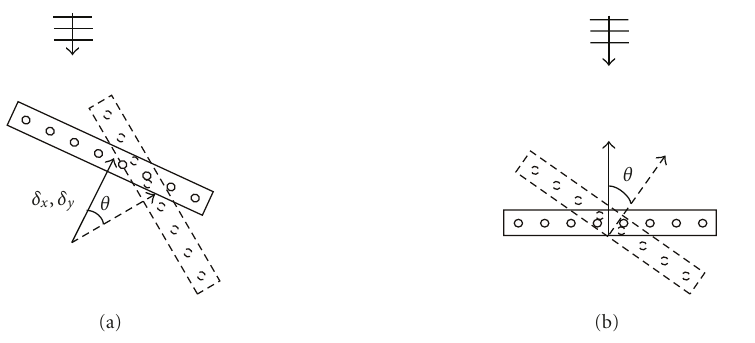
Figure 1: Schematic drawing of the antenna array with (a) and without (b) the displacement of the phase center relative to the origin of the coordinate system. Rotating the antenna array (solid) an angle θ gives a relative change (dashed) that depends on the distance to the origin ( δ x , δ y